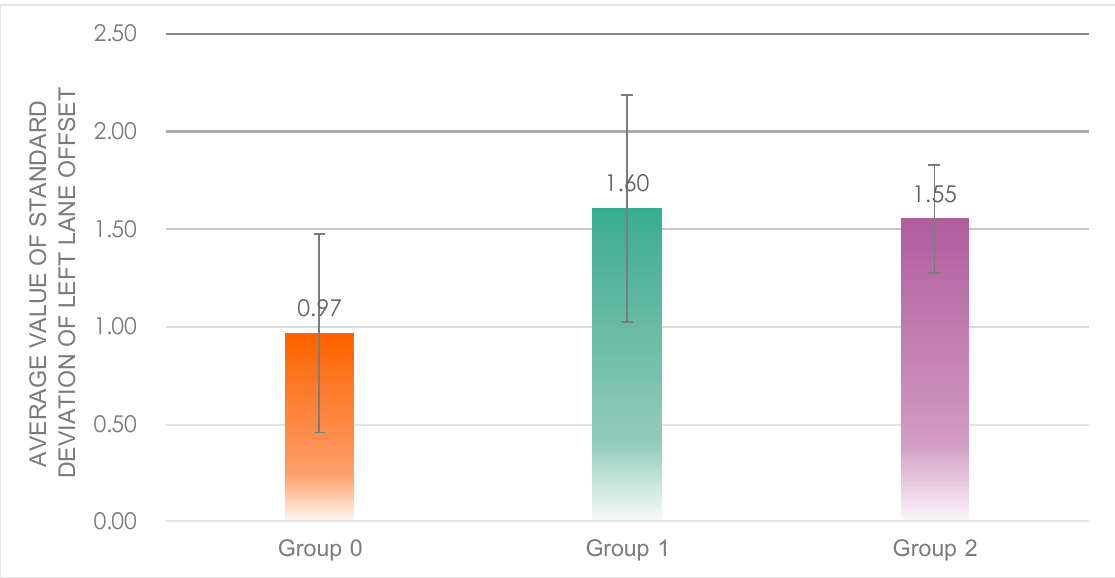
Figure 9. Average value of standard deviation of left lane offset of the three groups.